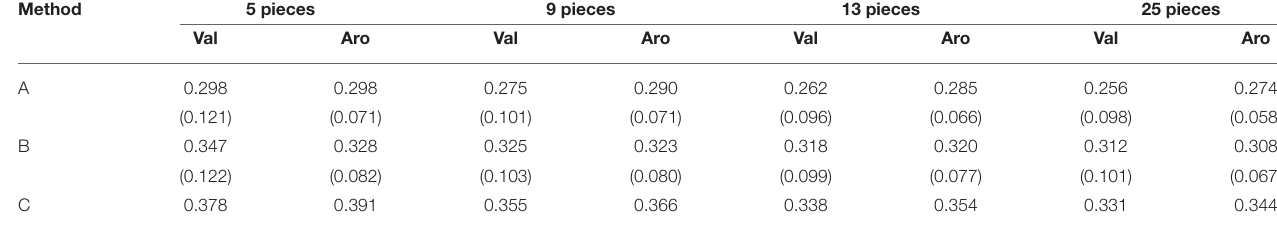
TABLE 2 | Participants’ mean and standard deviation of RMSEs of felt and predicted emotions using EEG data: Bold indicates RMSE of proposed method with a significant difference from baseline methods. Method